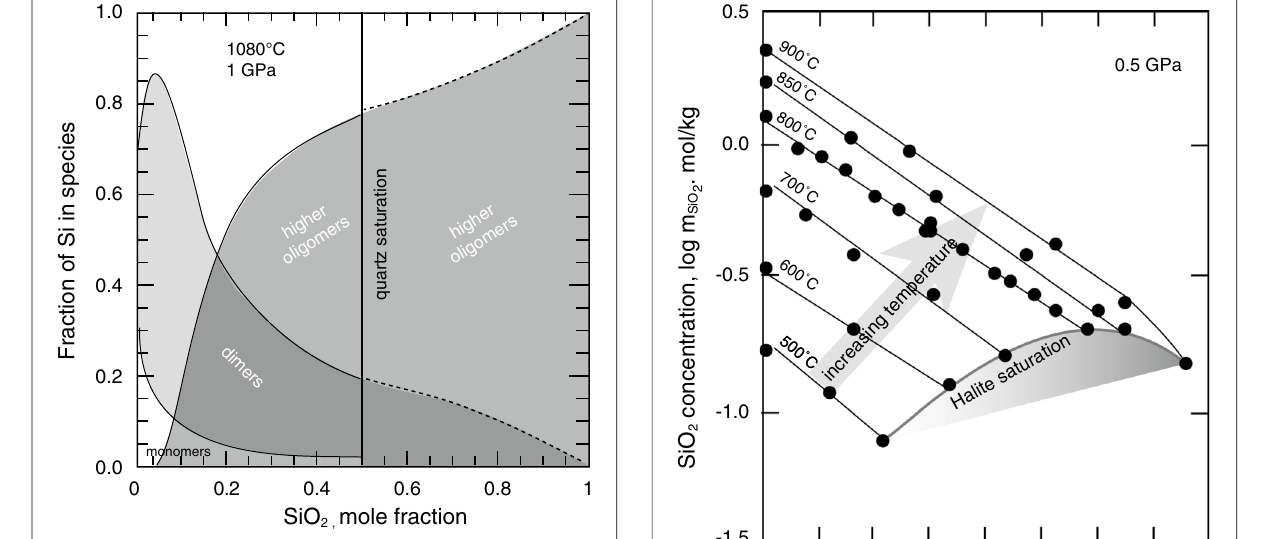
Fig. 11 Speciation of dissolved SiO 2 in aqueous fluid as a function of SiO 2 concentration in the fluid. Modified from Newton and Manning (2008)